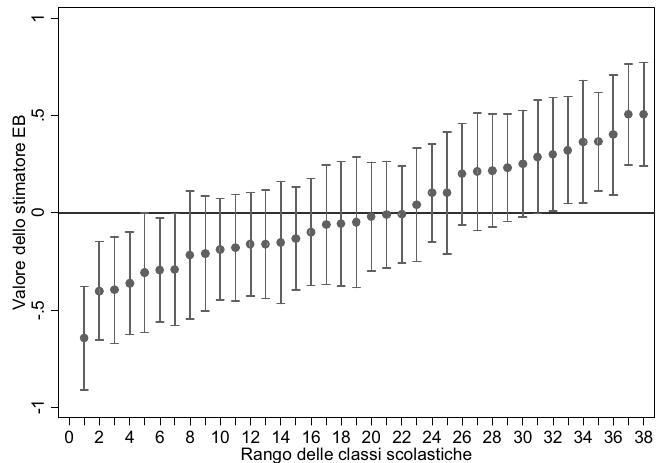
(cid:69) j 0 ˆ (cid:69) sono centrati j 0